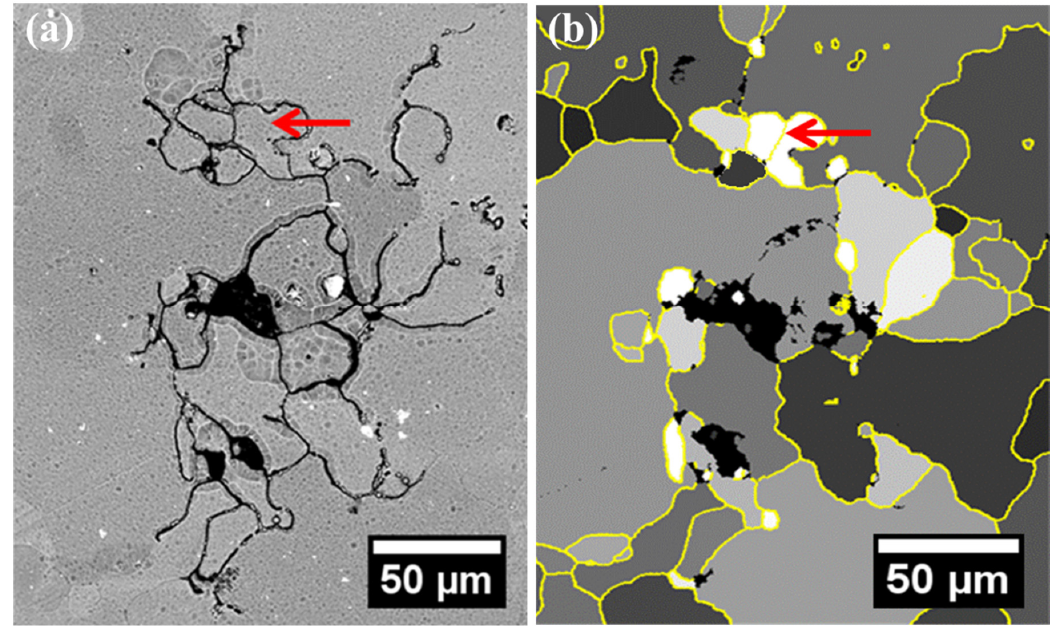
Figure 1. ( a ) SEM micrograph of a typical localized corrosion site after 10 h immersion in a 3.5 wt % NaCl solution; ( b ) the corresponding grain‐stored energy distribution in grey scale, with the yellow lines representing grain boundaries.